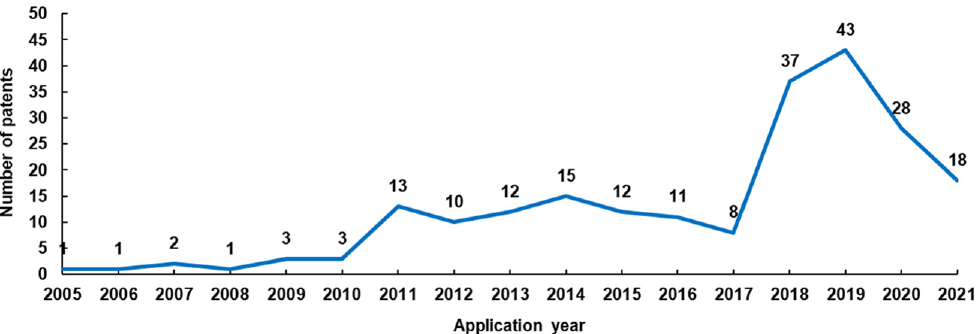
Figure 2. Number of lily-related cosmetics patents applied for in different years.